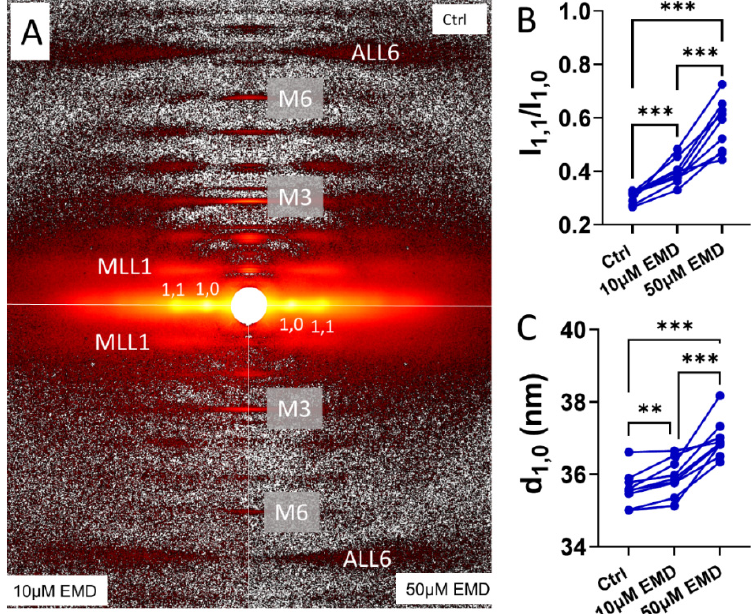
Figure 3. Effects of EMD on the equatorial reflections on the permeabilized pig myocardium. ( A ) Two dimensional diffraction pattern from the permeabilized resting pig myocardium in the absence (Ctrl, top half) and presence of 10 μ M (bottom left) and 50 μ M (bottom right) ,of EMD. ( B ) Equatorial intensity ratio from the permeabilized pig myocardium in the absence and presence of 10 μ M and 50 μ M EMD. ( C ) Lattice spacing from the permeabilized pig myocardium in the absence and presence of 10 μ M and 50 μ M EMD. ** p < 0.01, *** p < 0.001.